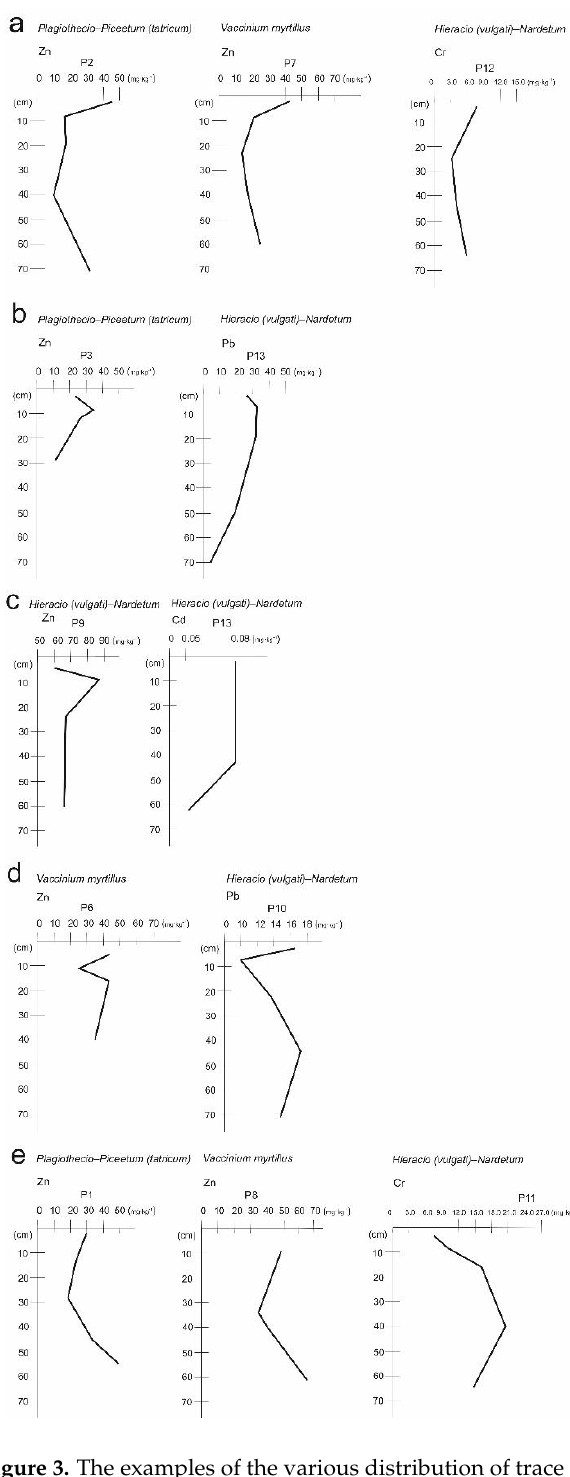
Figure 3. The examples of the various distribution of trace elements in soils under study. Explana- tion: ( a ) trace elements distribution as resulting from the podzolization process; ( b ) trace elements decreased with depth in the soil profile; ( c ) partially homogenous distribution of trace elements; ( d ) increasing of trace elements content in eluvial horizons, ( e ) enrichment with trace elements in BsC/BC horizon.